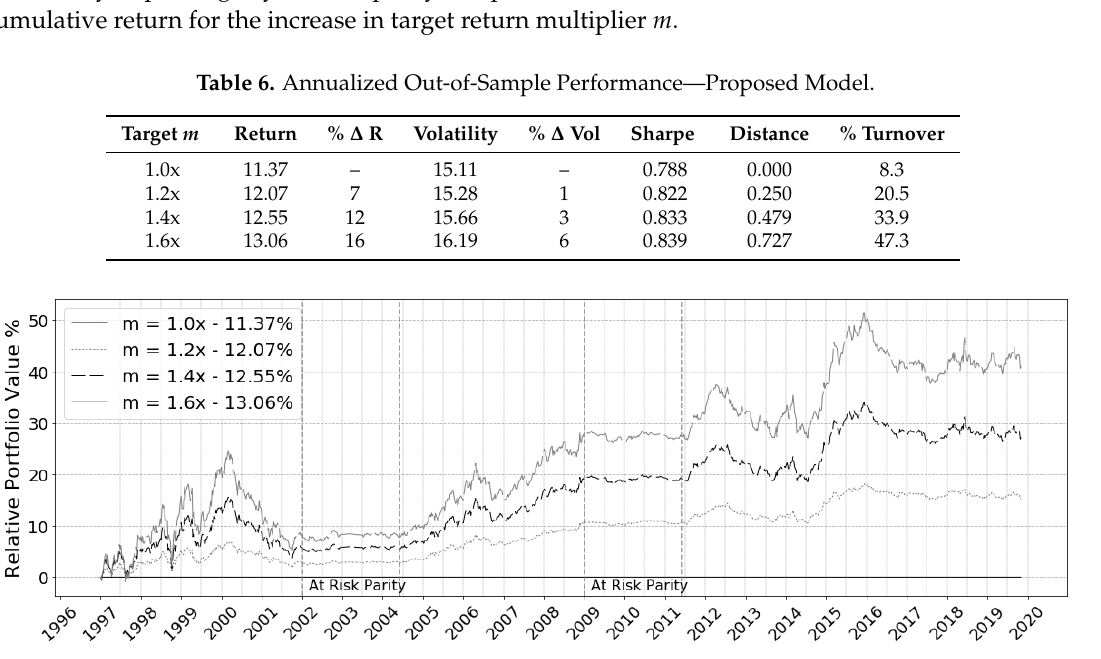
Figure 9. Relaxed Risk Parity Relative Out-of-Sample Cumulative Performance to